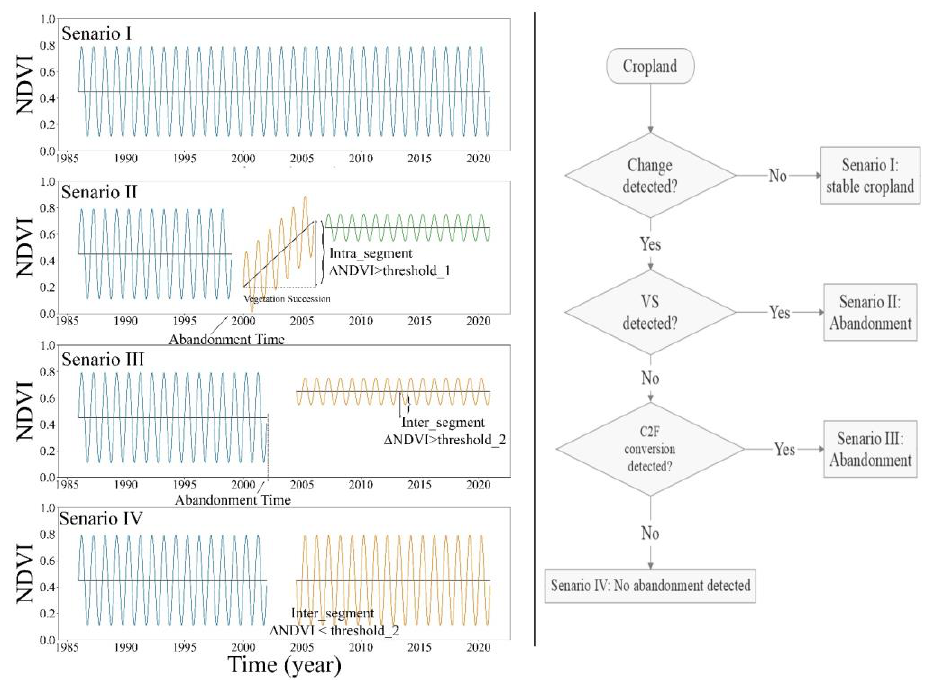
Figure 5. Four scenarios of cropland dynamics, based on which a decision tree is designed for scenario classification.